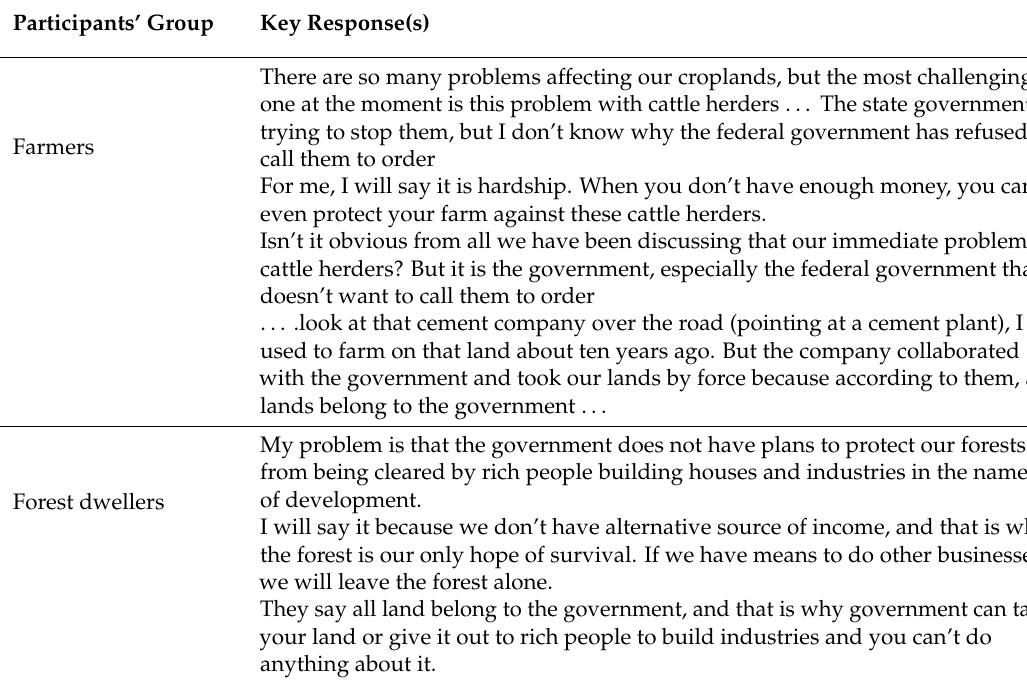
Table 4. Proximate and underlying factors driving agricultural land-use change within the last five years in Benue State, Nigeria from different stakeholders’ perspectives. Participants’